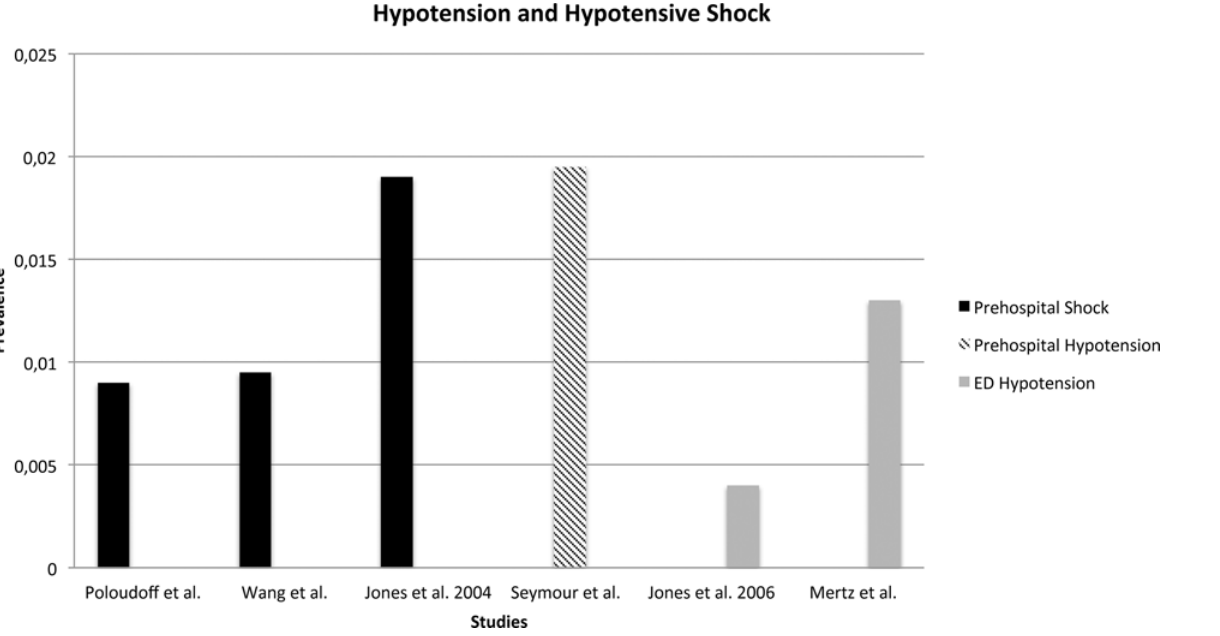
Fig 2. Prevalence of hypotension and hypotensive shock based on